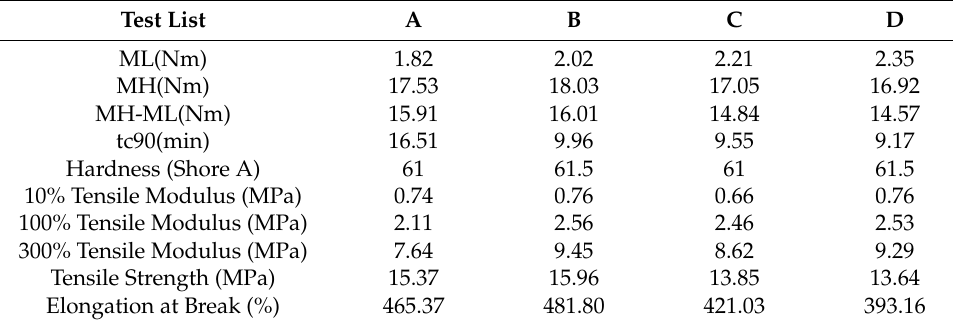
Table 2. The vulcanization data of the